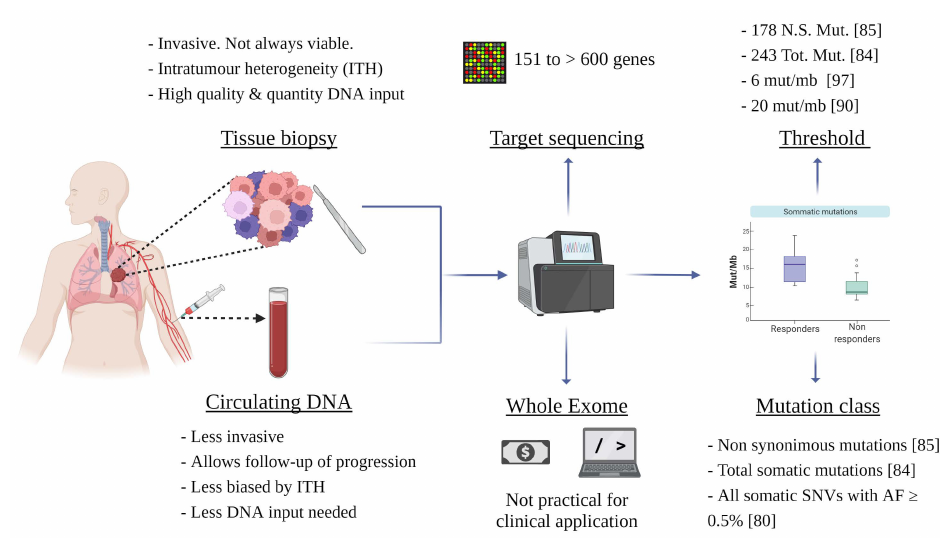
Figure 2. Lack of standardization for TMB assessment methodologies, criteria, and thresholds. Here we represent the overview of the subsequent stages of TMB determination, which still lacks standard- ization. N.S. Mut.: Nonsynonymous Mutations; Tot. Mut: Total Mutations; mut/mb: Mutations per megabase; SNVs: Single nucleotide